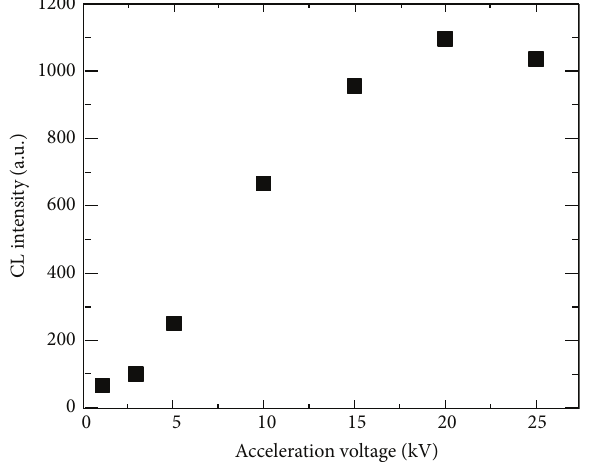
Figure 5: Output CL intensity of the lamp at 180 nm for acceleration voltages ranging from 1 to 2.5